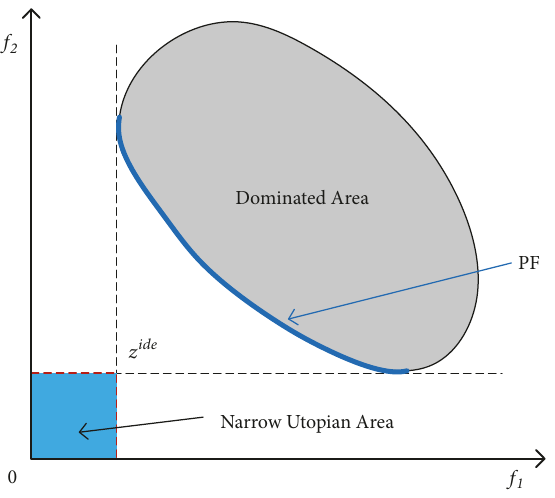
Figure 4: Illustration of a utopian point, narrow utopian area, and dominated